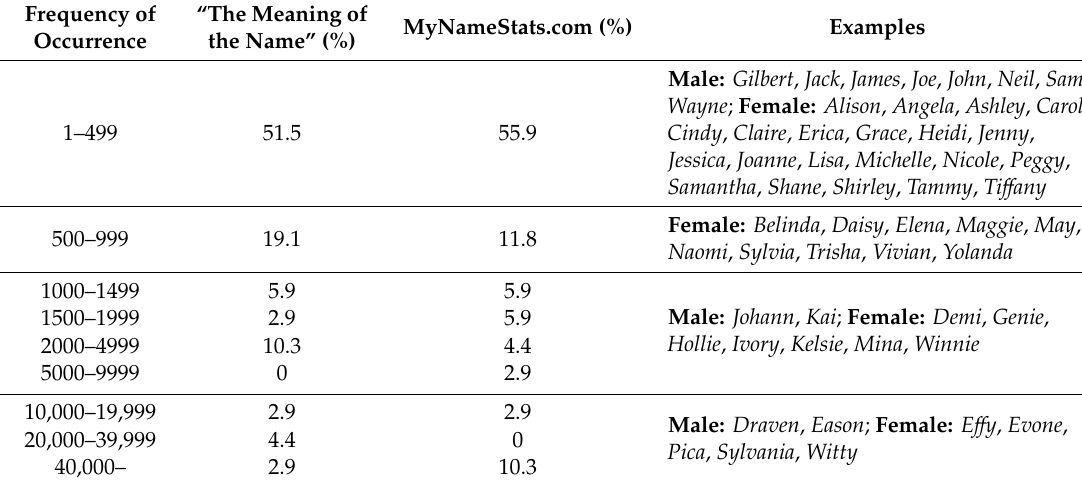
Table 1. Frequency of occurrence of the respondents’ English names.